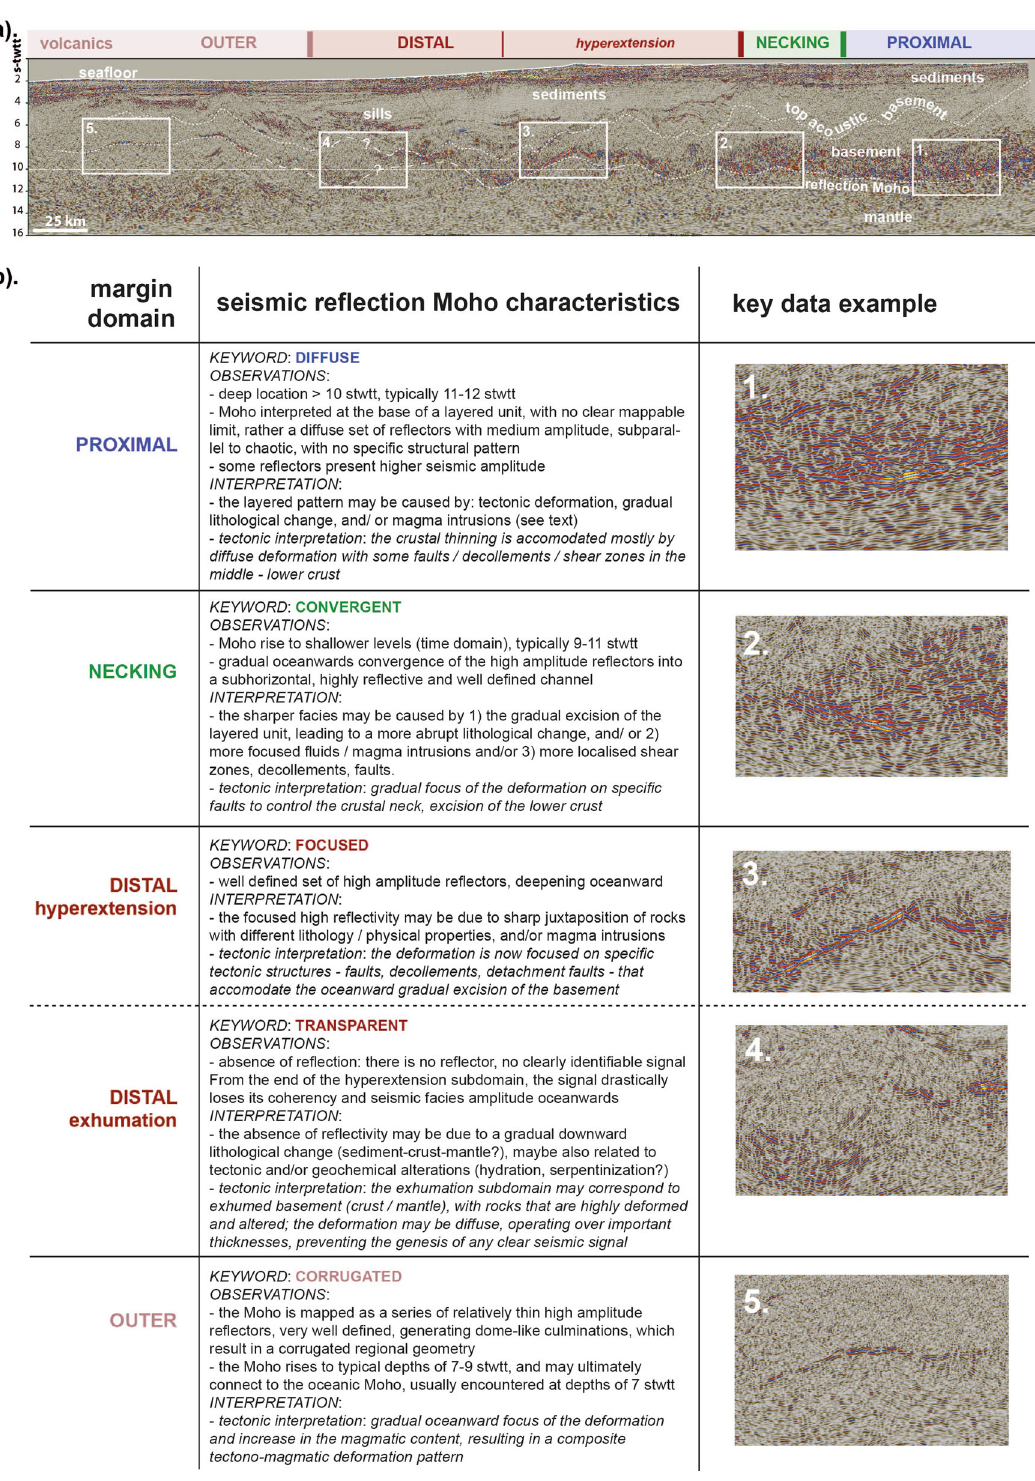
Fig. 2 List of the seismic facies and geometrical characteristics of the seismic re fl ection Moho. a Seismic re fl ection pro fi le selected as representative of the global architecture of the Norwegian Continental Shelf. See Fig. 1 for location. Geoex MCG RDI19 dataset. The top acoustic basement and Moho are outlined with thin dashed white lines. The white boxes locate the pro fi le extracts displayed in the table below. b List of the characteristics of the seismic re fl ection Moho observed in the different rifted margin domains — including a succinct summary of the seismic facies and geometries, and a tentative geologic and tectonic